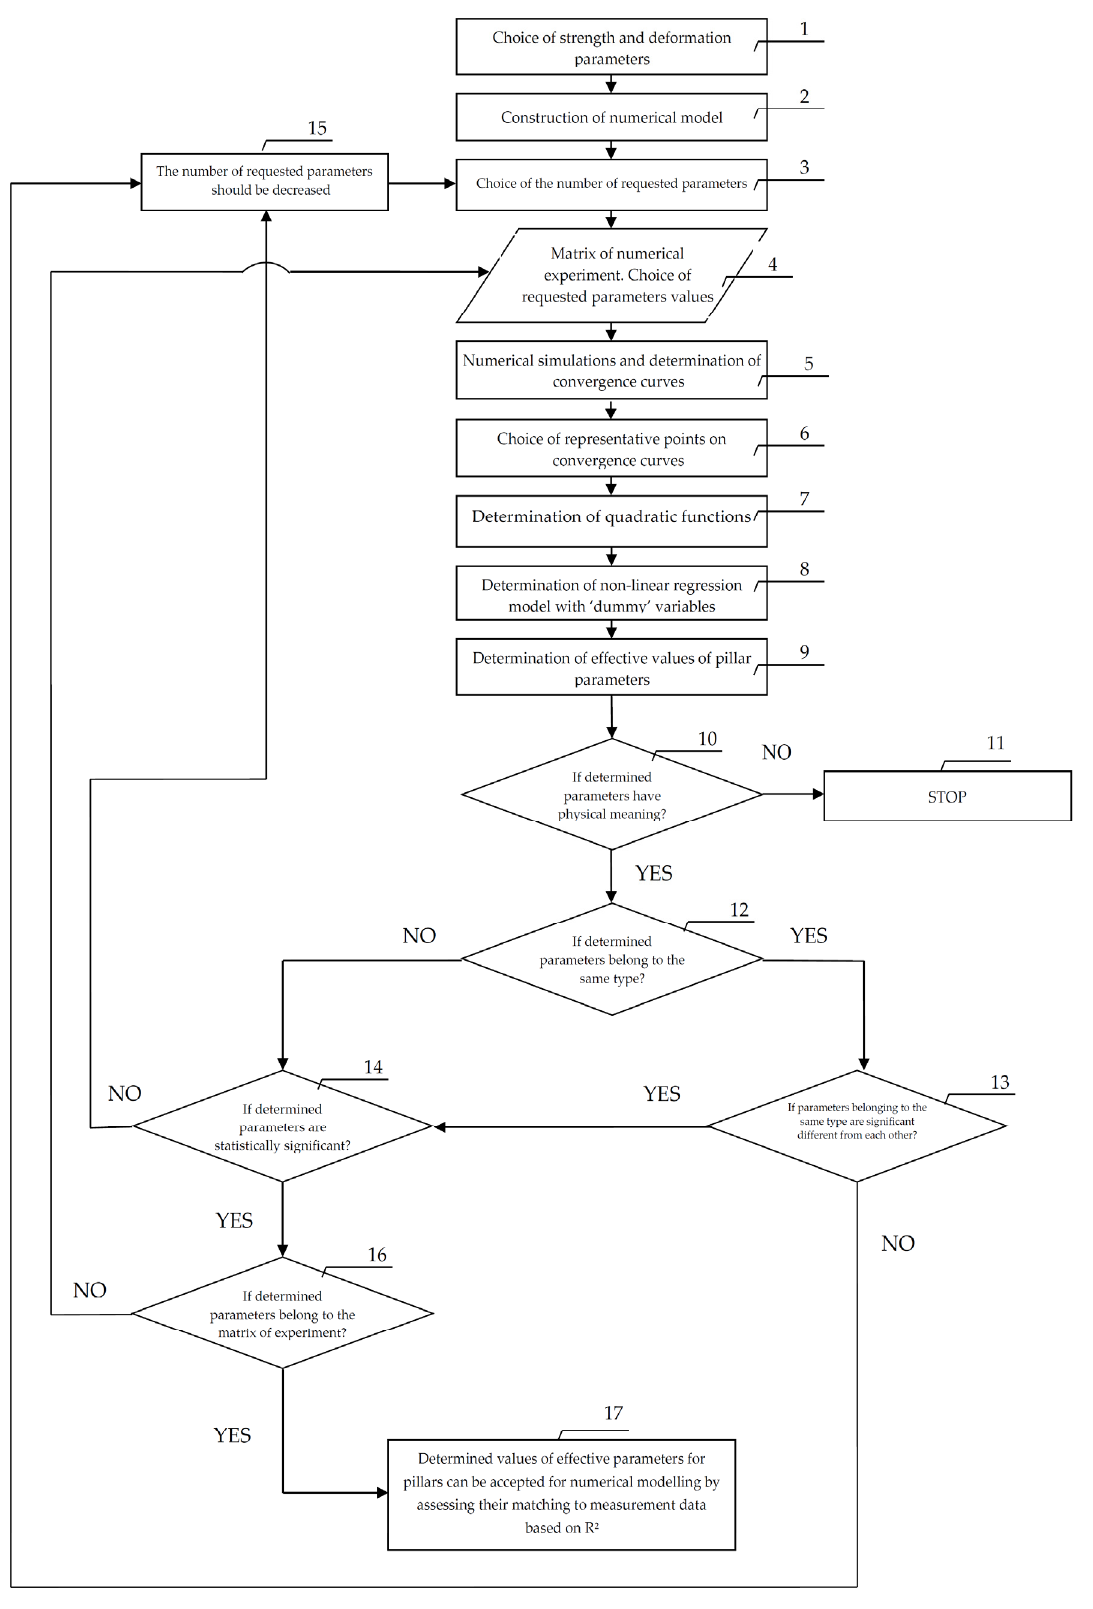
Figure 1. Method of determination of effective geomechanical pillar parameters on the basis of numerical simulations and measurement data using statistical methods.